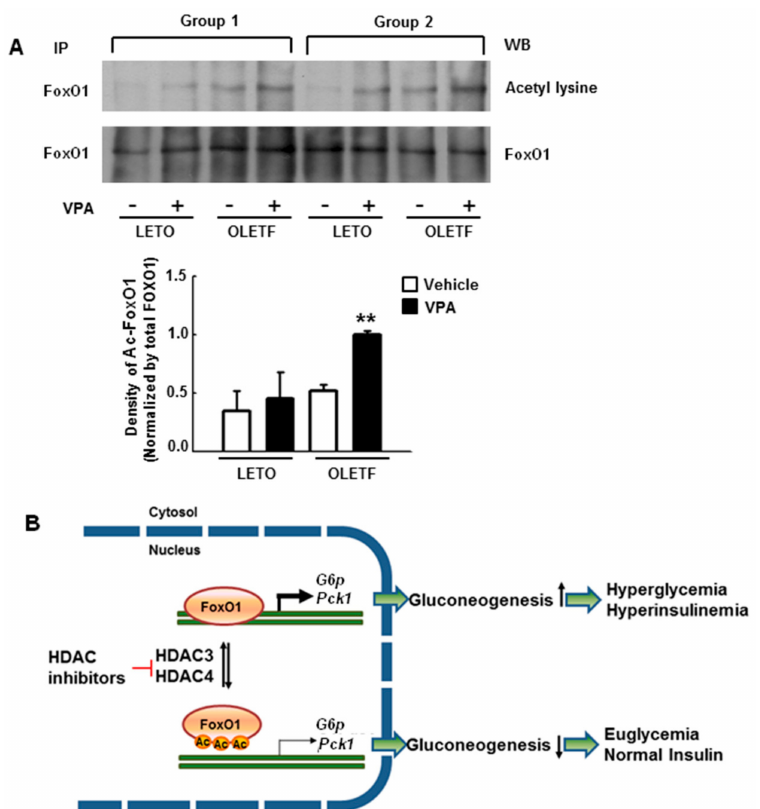
Figure 8. VPA maintains acetylation of FoxO1 and attenuates hyperglycemia in type 2 diabetic rats. FoxO1 protein was not significantly different between LETO and OLETF rats regardless of VPA treatment ( A ); FoxO1 acetylation was analyzed by western blot with anti-acetyl-lysine antibodies after immunoprecipitation (IP) with anti-FoxO1 antibodies. A representative immunoblot showing that FoxO1 acetylation is increased by VPA administration is presented. Data show the mean ± SEM of five independent experiments (** p < 0.01 vs. vehicle OLETF); ( B ) A summary of the involvement of histone deacetylase (HDAC) inhibitors in gluconeogenesis is shown. HDAC inhibitors increased acetylation of FoxO1 by inhibiting HDAC3 and HDAC4, which interfered with the DNA binding activity of